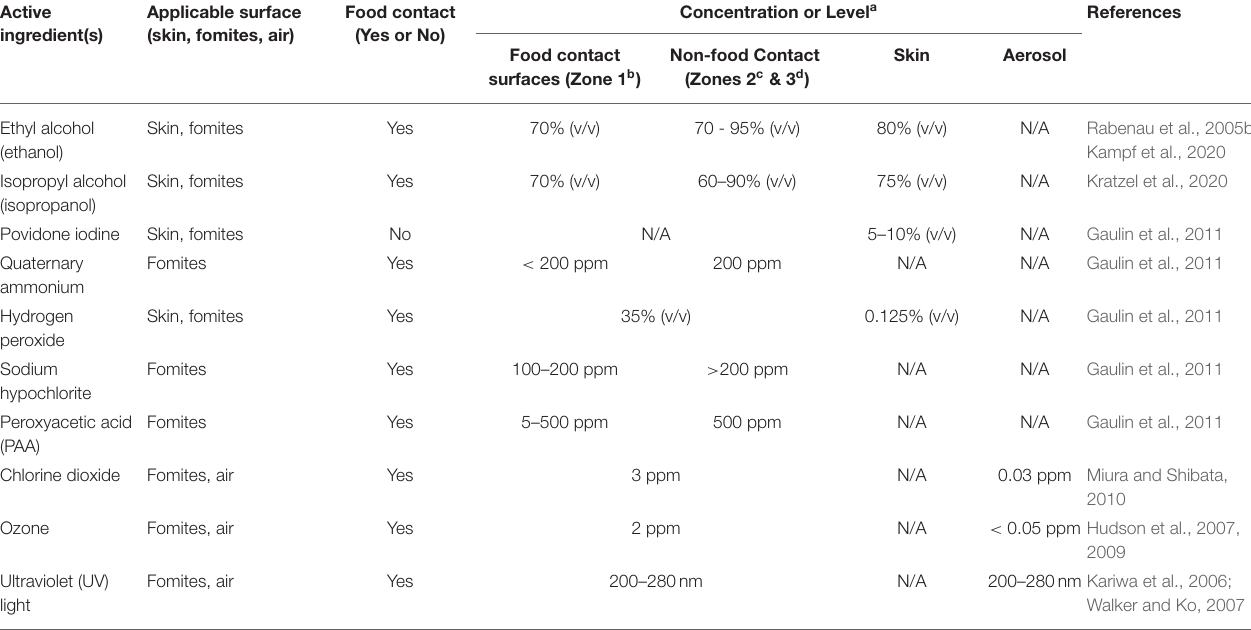
TABLE 1 | Overview of applications for biocides that are effective against coronaviruses. Active